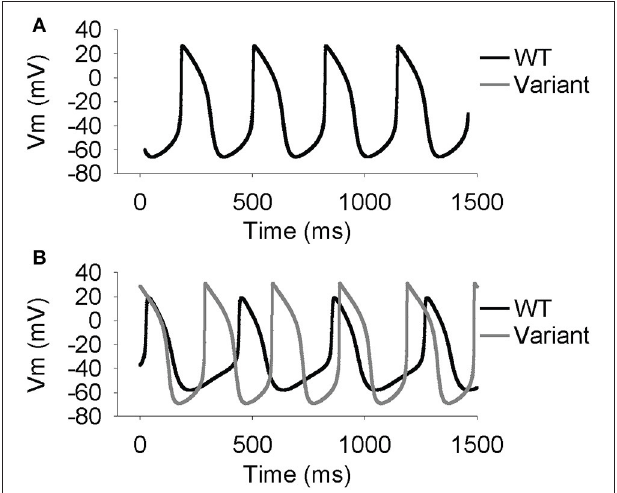
FIGURE 2 | Simulated spontaneous SAN action potentials in one WT cell and one cell with lognormally perturbed ion channel factors. Simulations were run to steady state (50s). (A) At a conductivity of 0.33 (1/ (cid:127) -cm), which is the normal conductivity between two WT cells, the cells synchronize both the voltages and the times at which they fire. (B) At a conductivity of 0 (1/ (cid:127) -cm) the cells are uncoupled and act the same as if they were run independently.